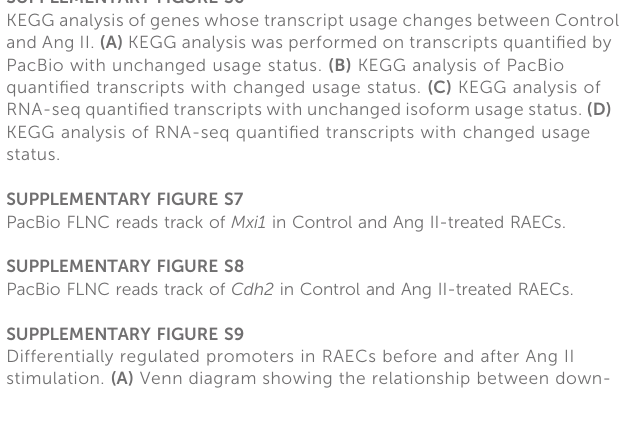
SUPPLEMENTARY FIGURE S13 RNA-seq track for gene Cdh2